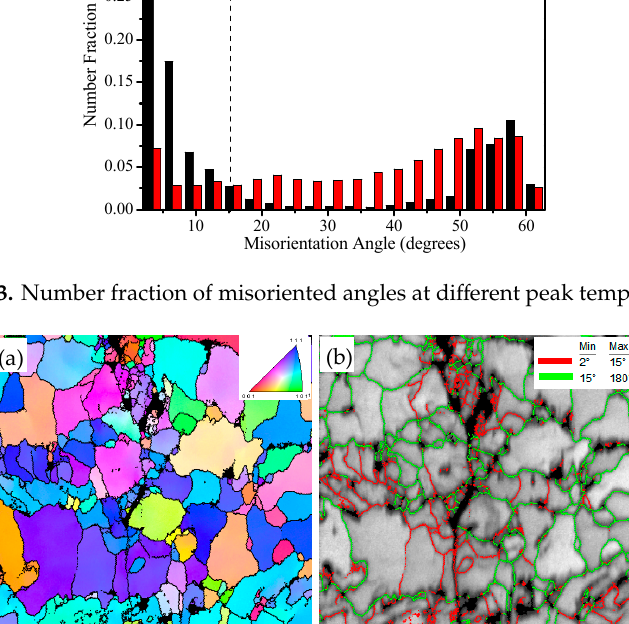
Figure 14. Crystallographic characteristics of the fatigue cracks at peak temperature of 850 °C. ( a ) Orientation image maps; ( b ) Image quality maps with grain boundary misorientation distribution.